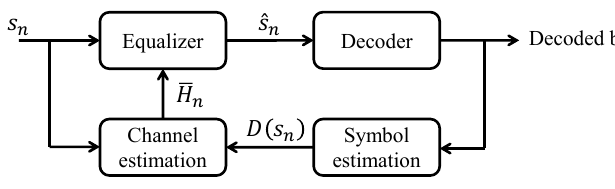
Figure 5. A block-diagram description of a Turbo equalizer.